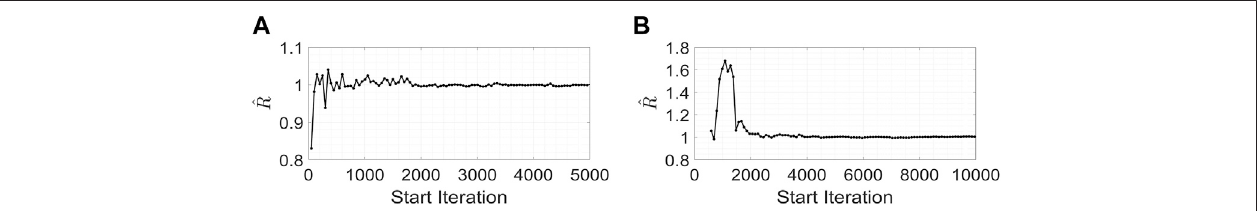
FIGURE 4 | The convergence of MCMC simulation is ensured by computing the Gelman-Rubin statistic (cid:25) R (Gelman and Rubin, 1992) corresponding to various startingiterationsteps (A) theMCMCsamplesconvergetothetargetstationarydistributionafter5,000samples (B) theMCMCsamplesbeyondtheinitial5,000samples converge to the target stationary distribution.